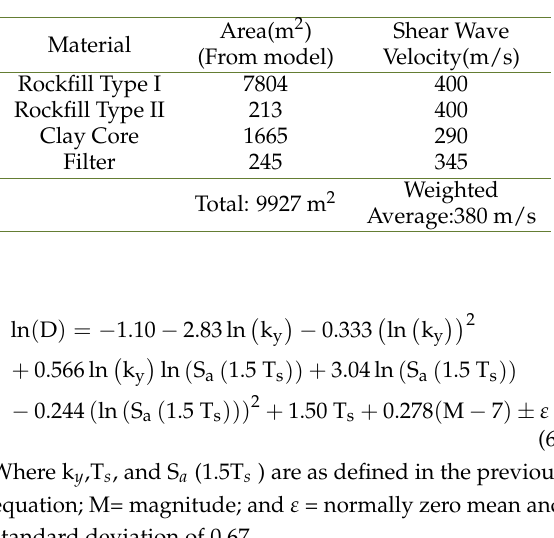
Table 4. Weighted average of the shear wave velocity of the rockfill